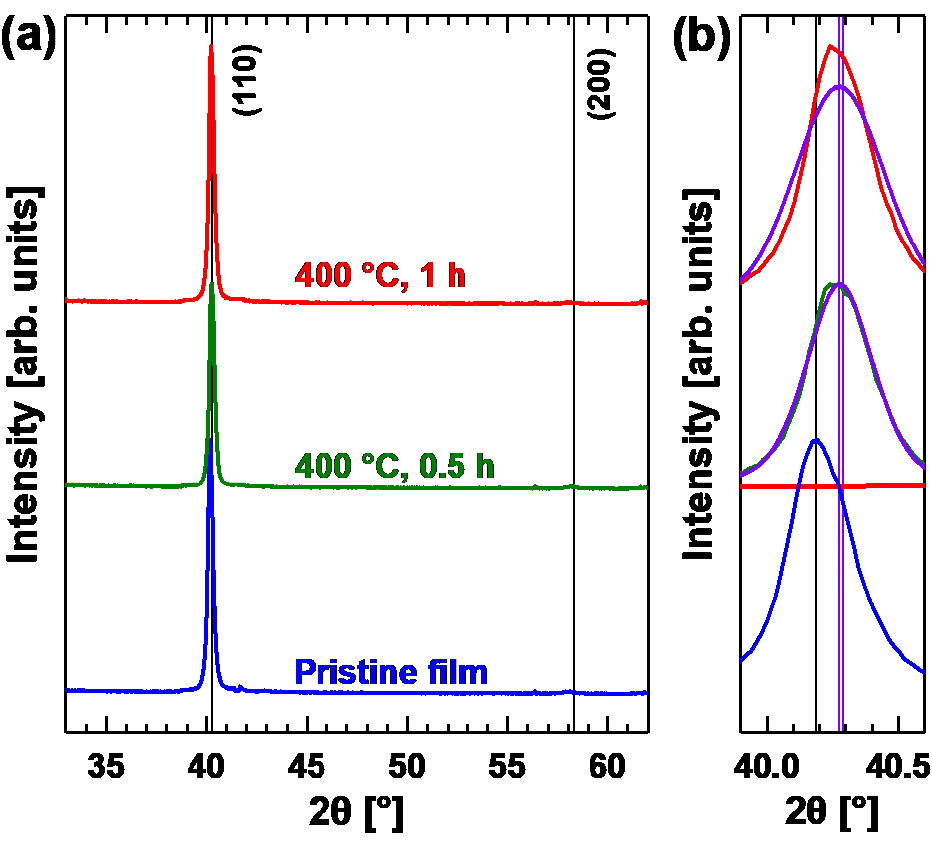
Figure 8. ( a ) XRD patterns of the WTi alloy film with 6.8 at.% Ti after vacuum annealing at 400 °C for 0~1 h and ( b ) expanded-scale XRD patterns around the W (110).